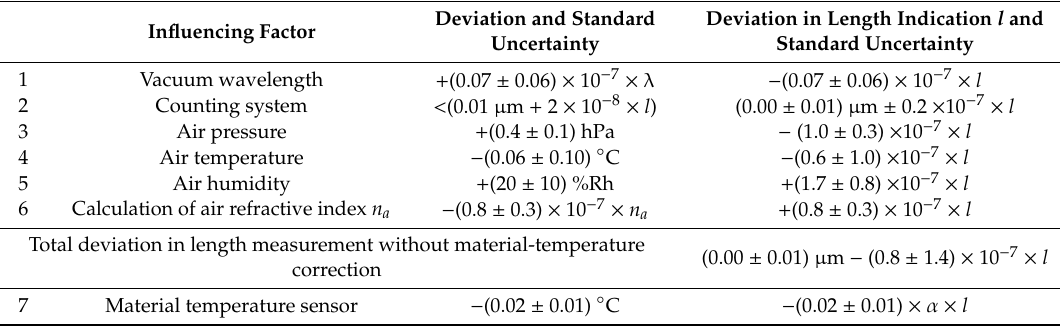
Table 11. Typical summary table of the result of a laser interferometer calibration. Deviation and Standard Influencing Factor